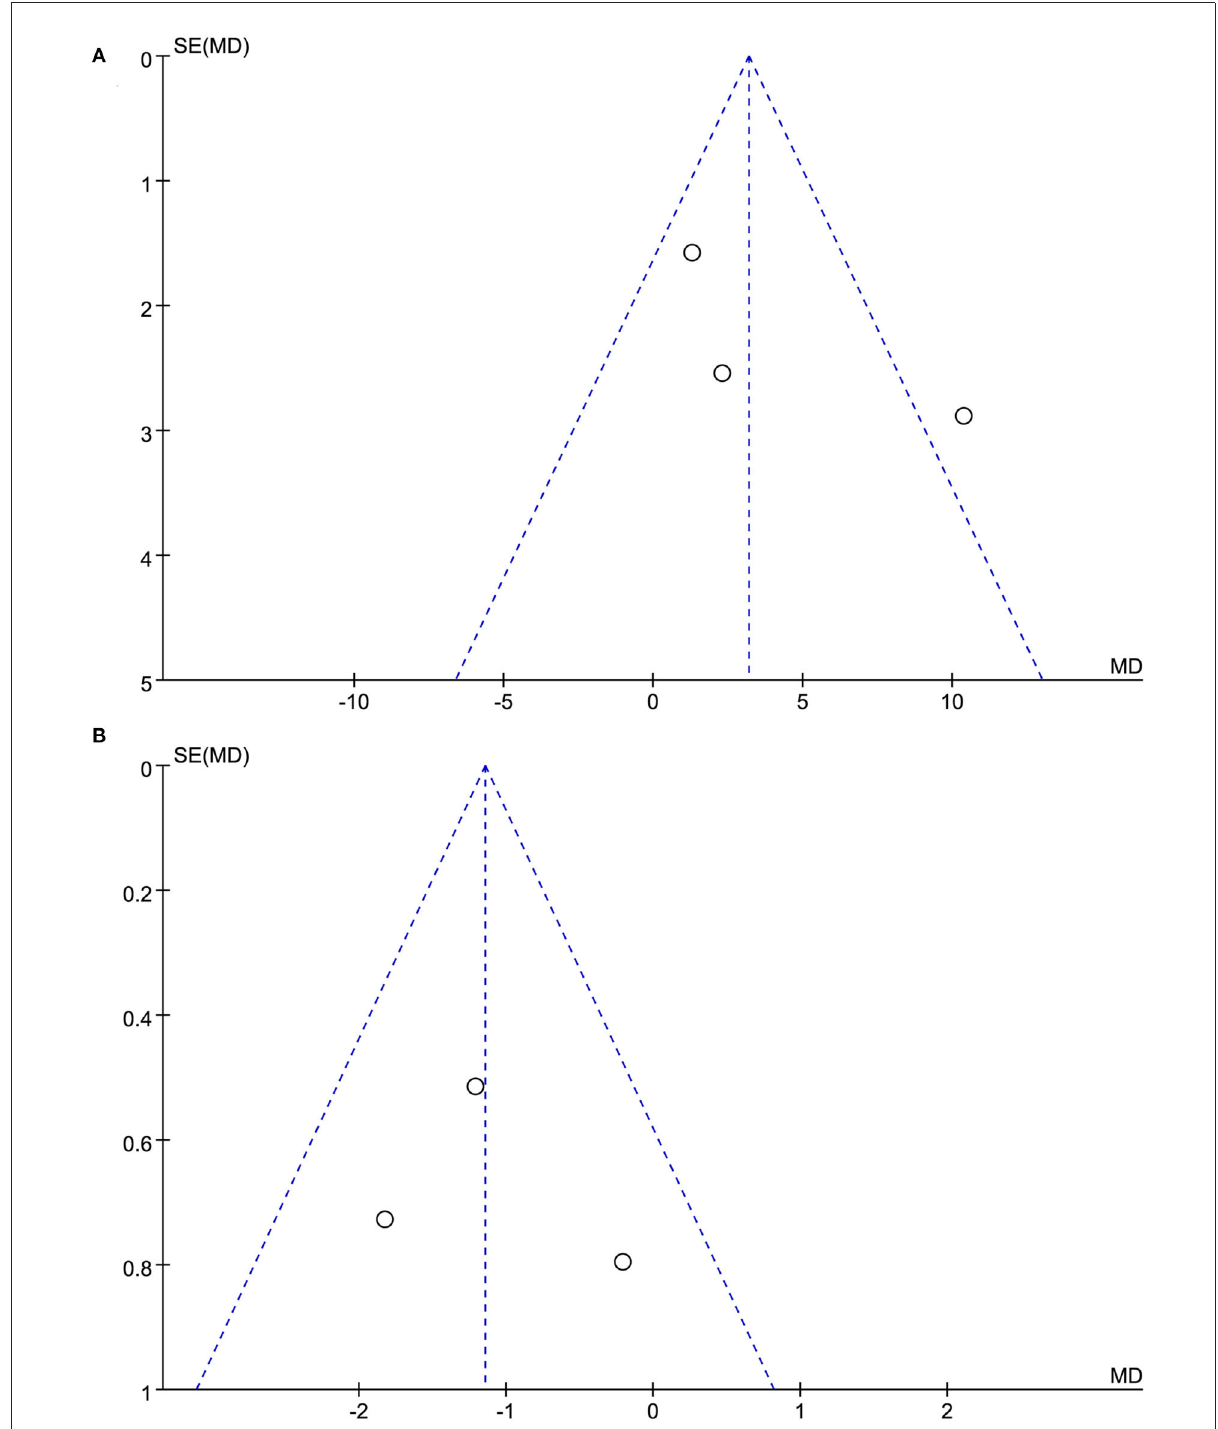
FIGURE3 (A) The funnel plots of acupuncture on neurotoxicity and associated dysfunction. (B) The funnel plots of acupuncture on neuropathic